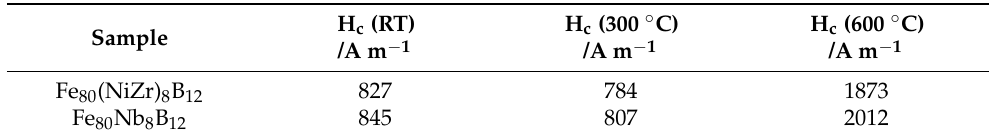
Table 6. Coercivity, H c , of compacted specimens at room temperature (RT) and after annealing (30 min) at 300 or 600 ◦